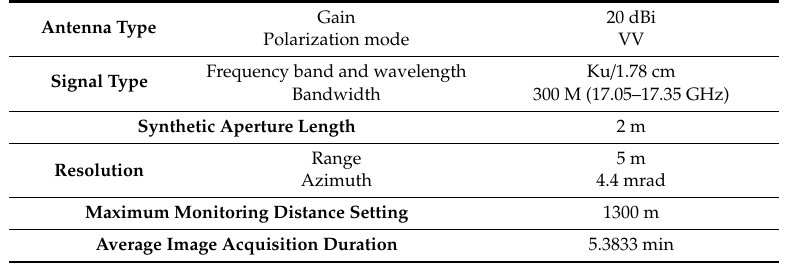
Table 1. Basic equipment information for GB-SAR for deformation monitoring experiment.